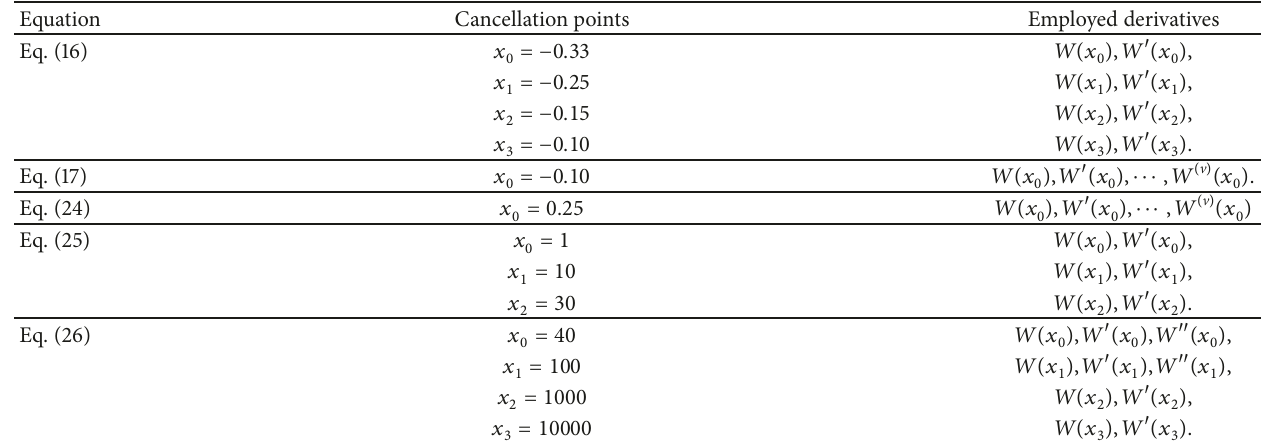
Table 3: Parameters for PSEM